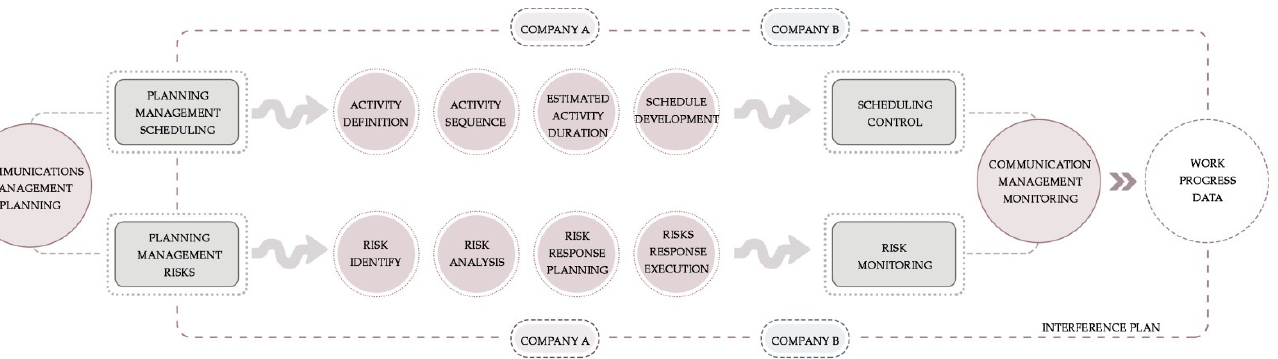
Figure 7. Interference plan framework—Model Smart Management.